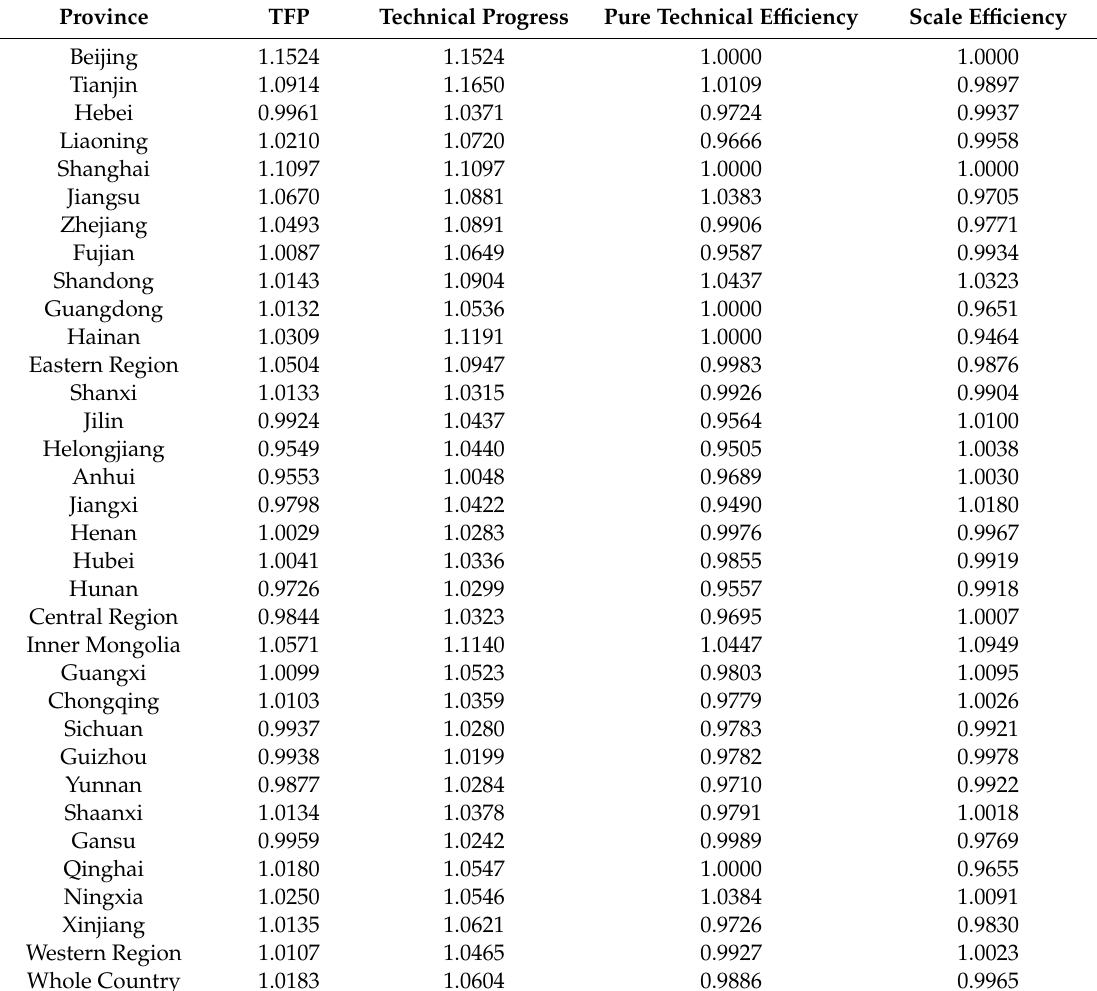
Table 2. TFP index of China’s provinces in 1997–2017 and its decomposition.